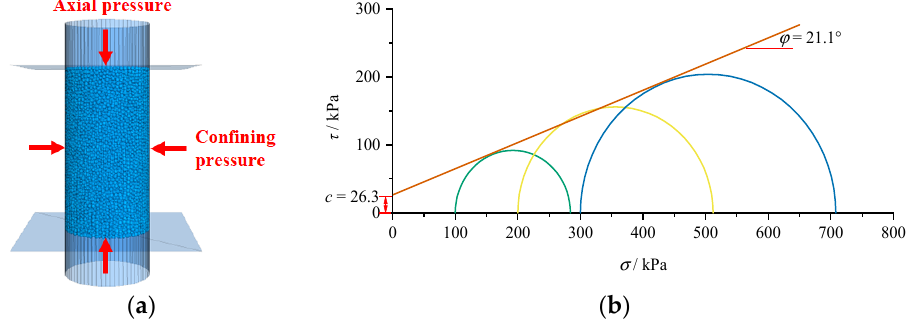
Figure 11. Parameters calibration: ( a ) the model used in the biaxial compression tests, ( b ) Mohr failure envelopes.